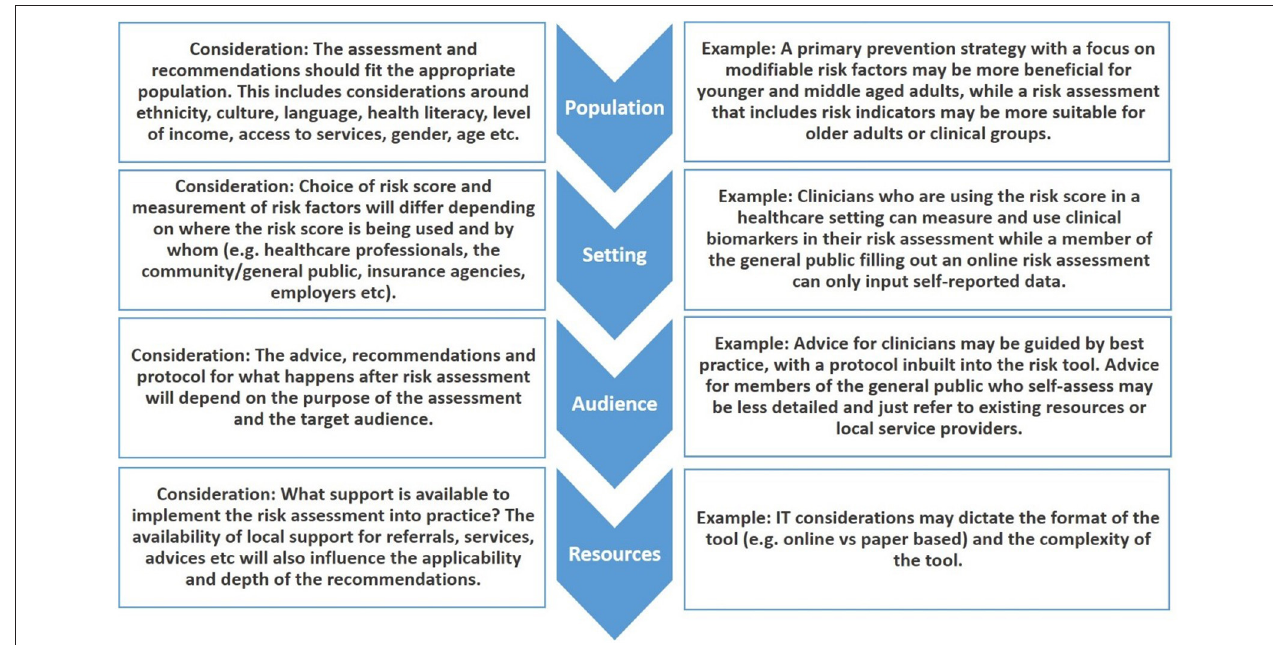
FIGURE 2 | Considerations for selecting or developing risk score for local